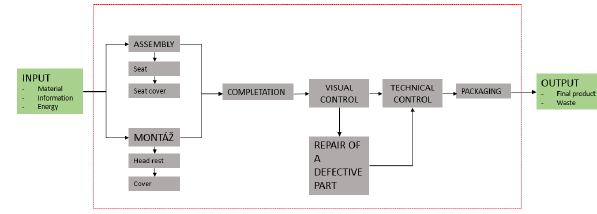
Figure 1: The production process